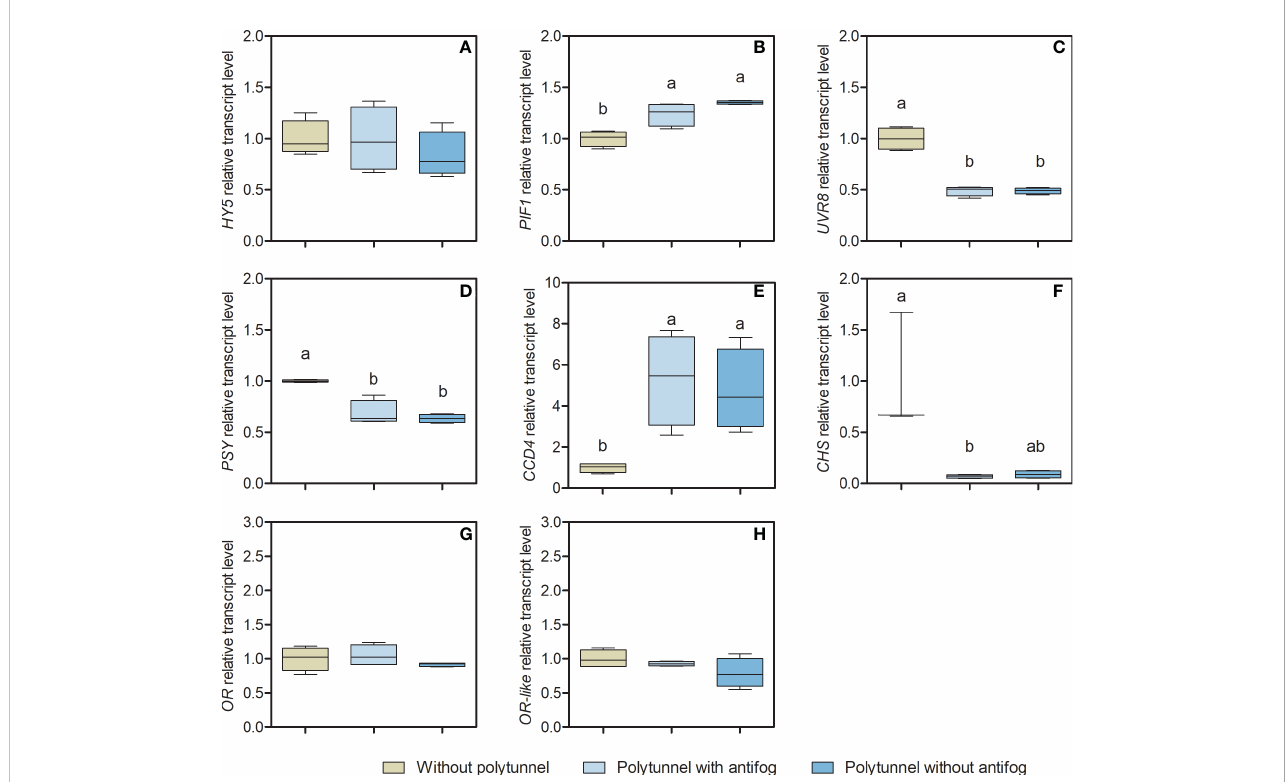
FIGURE 5 Gene transcripts for key enzymes of the core carotenoid and fl avonoid biosynthesis pathways. Transcript levels of (A) HY5 , (B) PIF1 , (C) UVR8 , (D) PSY , (E) CCD4 , (F) CHS , (G) OR , and (H) OR-like in lettuce grown without or under polytunnels with and without antifogging additives. The fi rst experimental repetition in April is shown. The data are expressed as Box-Whisker-Plots (n = 4); Whiskers show maximal and minimal values. Data was normalized to lettuce grown without polytunnels. Different letters indicate signi fi cant differences (p ≤ 0.05) of transcripts under different cultivation conditions; no letters indicate absence of signi fi cance. HY5 , Elongated hypocotyl5; PIF1 , Phytochrome interacting factor1; UVR8 , Ultraviolet resistance locus8; PSY , Phytoene synthase; CCD4 , Carotenoid cleavage dioxygenase4; CHS , Chalcone synthase; OR , Orange protein; OR-like , Orange-like